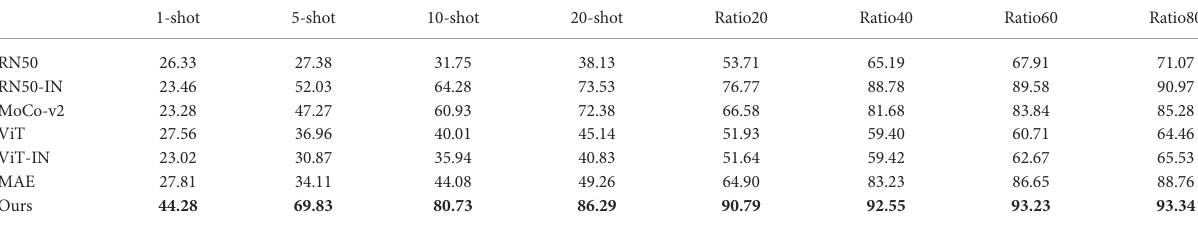
TABLE 4 The mean testing accuracy mAcc of different training methods over the 12 datasets for plant disease recognition detailed in Table 1 . .